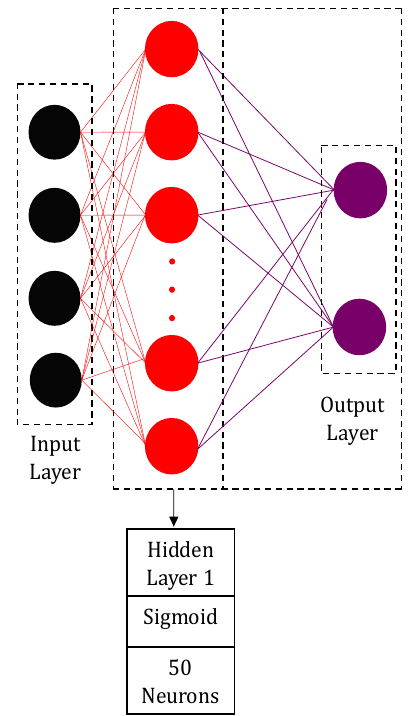
Figure 3. Shallow neural network supervised training.